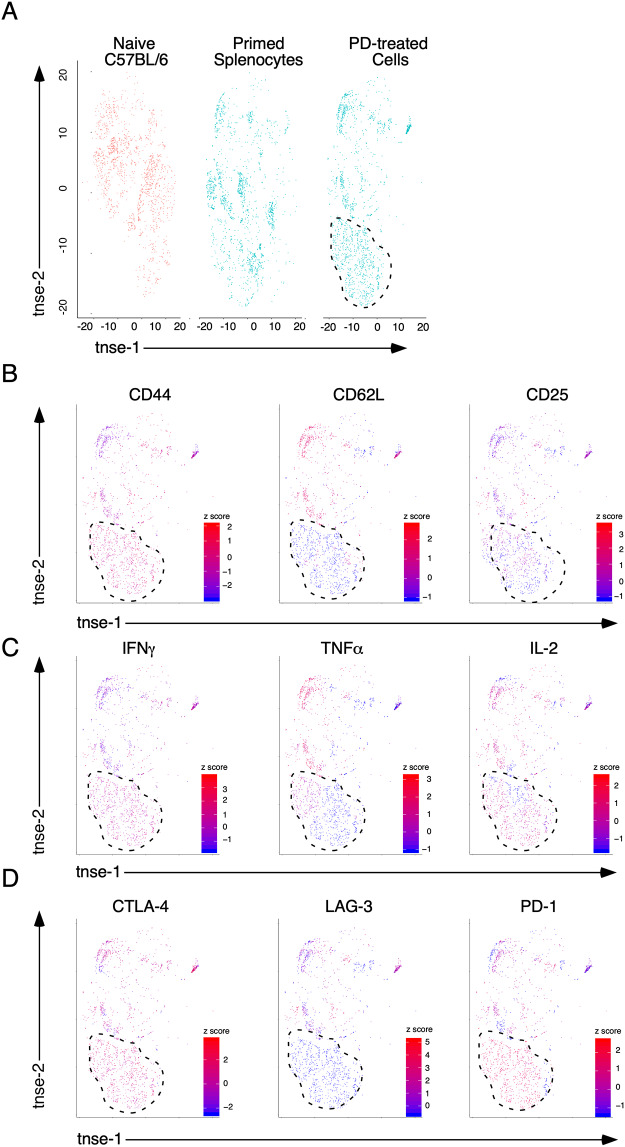
Photodepletion with 2-Se-Cl enriches polyfunctional T cells with upregulation of inhibitory receptors.(A) t-SNE transformation was performed on high-dimensional FACS data obtained from the analysis of isolated PBMCs from naïve C57BL/6 mice, and on primed splenocytes before and after PD. Area outlined by dotted line represents populations enriched by PD. Heat map analysis was performed of the individual variables mapped back to the z-score for each cell for (B) markers of effector status, (C) cytokine production, and (D) inhibitory receptor expression. Each group contains 9–15 mice in 3 independent experiments. Cells from multiple animals are included in each plot.